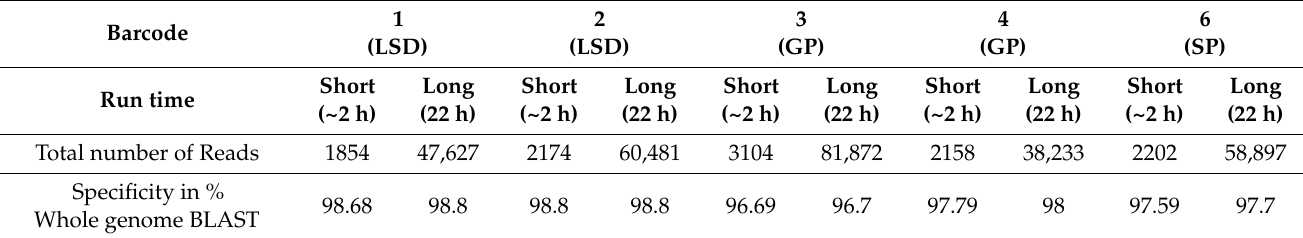
Table 2. Comparison between the specificities of short (~2 h) and long (22 h) sequencing protocols. Barcode